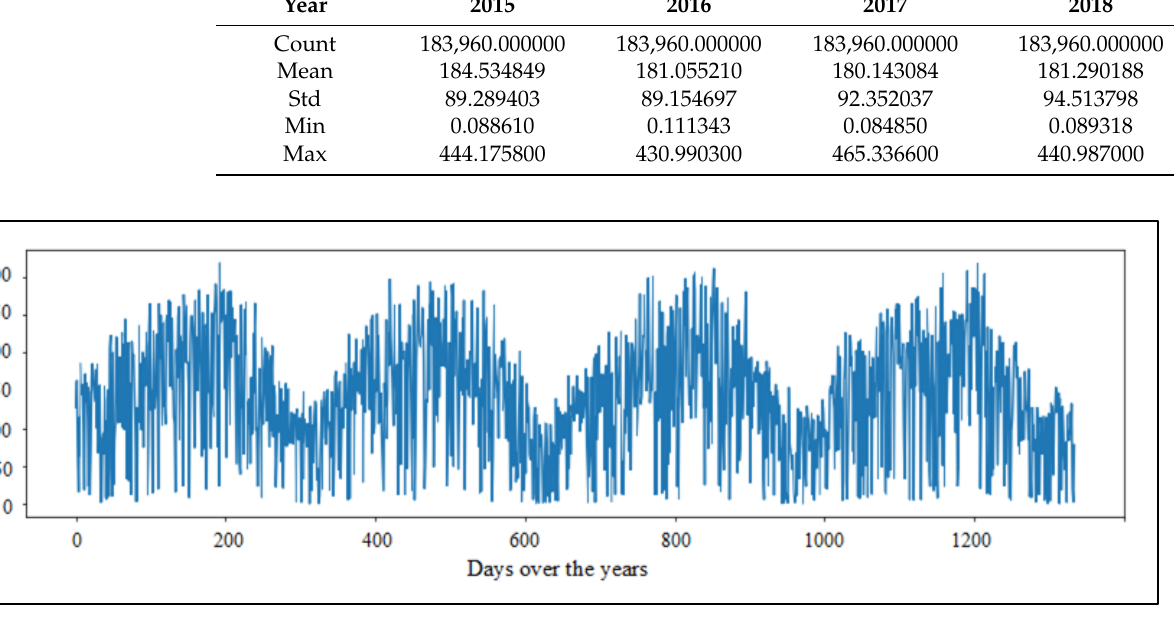
Figure 6. Schematic diagram of the application of the solar radiation data format for the ResNet model from 504 locations in the period 2015–2018. ( a ) Original time series of the 504 locations re- sulting in 183,960 data points per year. ( b ) Proposed data format, where n is the location number and d is the day of the year. ( c ) The final format of the data, where 70% of n locations were picked randomly for training the model and the remaining 30% of the locations for its evaluation. ( d ) Input and output time series.